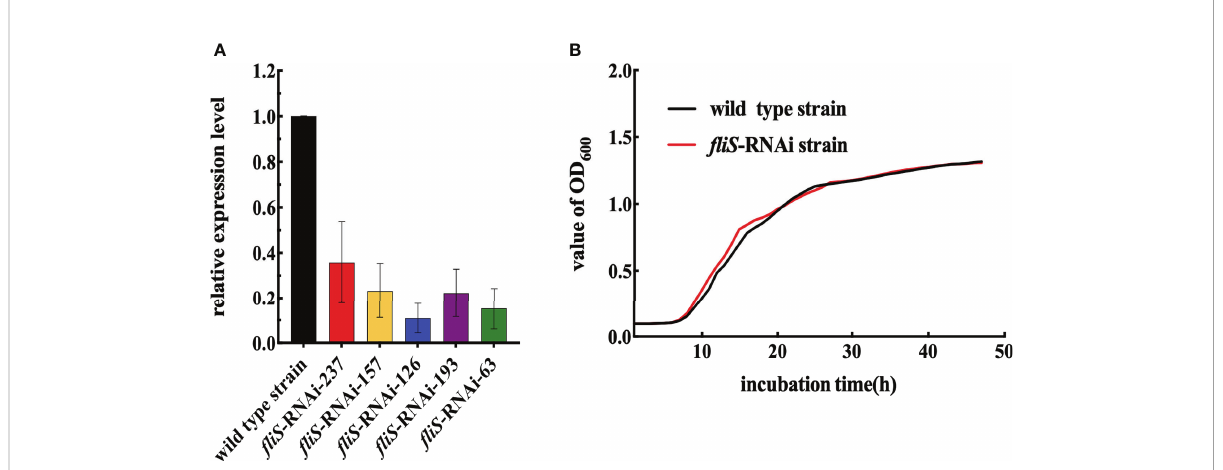
FIGURE 1 Construction and growth curve of P. plecoglossicida fl iS -RNAi strain. (A) fl iS mRNA levels of P. plecoglossicida strains. (B) Growth curve of wild type and fl iS -RNAi